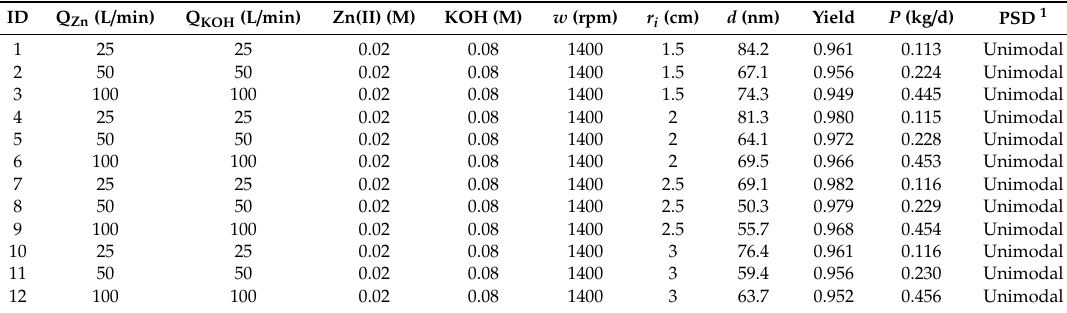
Table 2. Results obtained in the first 12